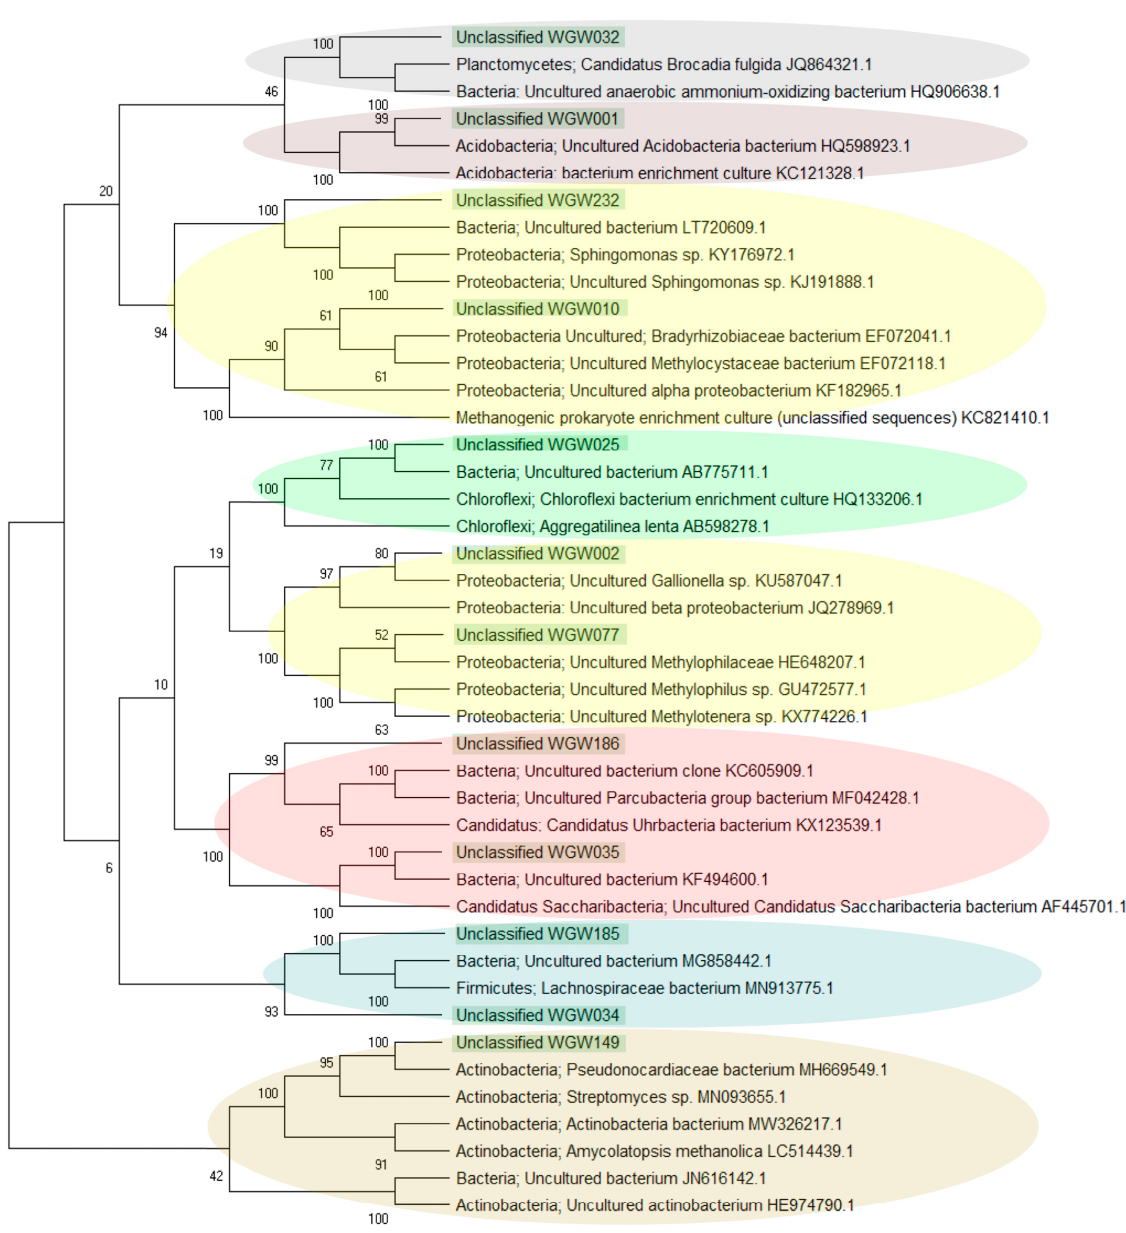
Figure 4. Evolutionary relationships of the unclassified sequences, where the numbers above the branches indicate the bootstrap value. Phylogenetic tree determined by the Neighbour-joining method using MEGA-X software. The clades belonging to the same taxa are marked with one colour.